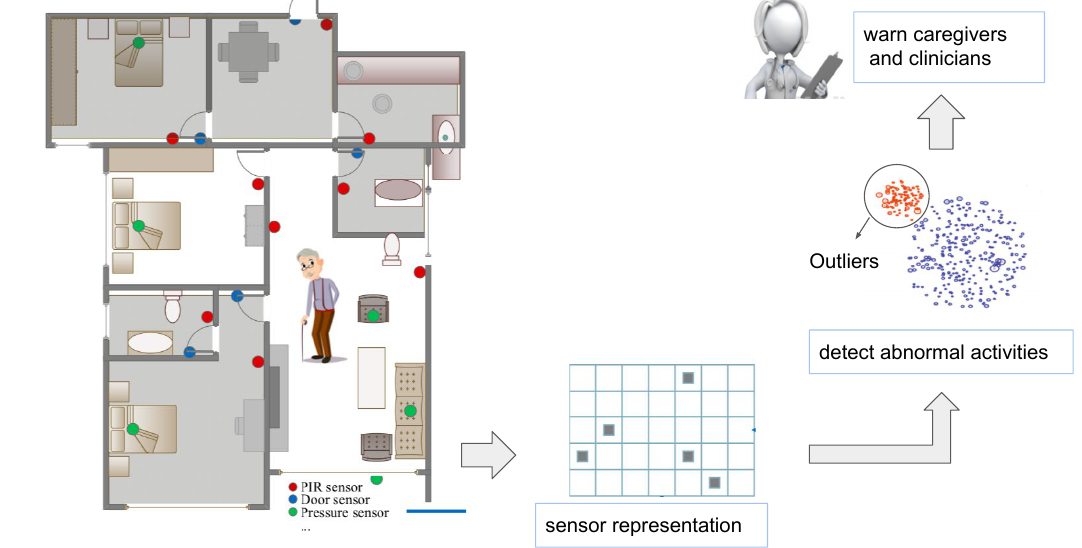
Figure 1. Overview of the proposed